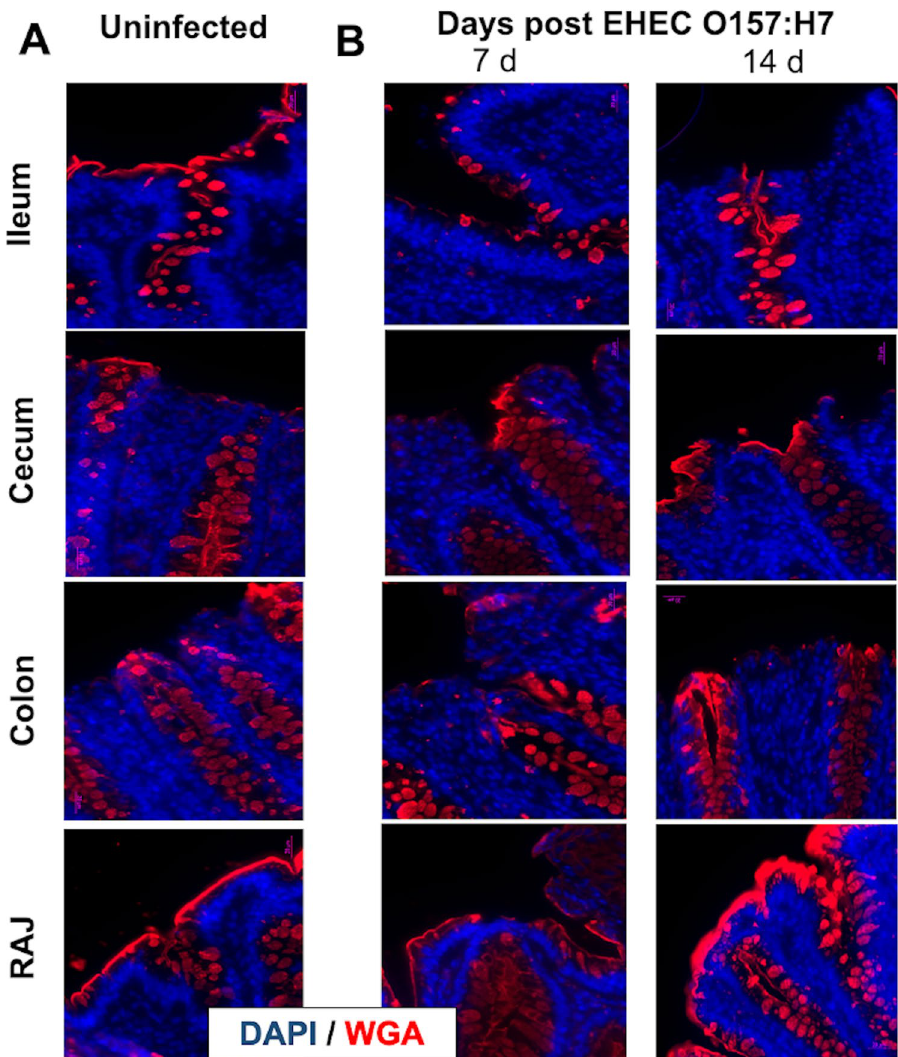
Figure 6. Microphotographs (lectin immunofluorescence with lectin wheat germ agglutinin; WGA) of cells producing N-acetyl-D-glucosamine and sialic acid (mucin) in the ileum, cecum, colon, and rectal anal junction (RAJ) of calves ( A ) uninfected and ( B ) challenged by EHEC O157: H7 (7 d and 14 d post-challenge). Infected small and large intestine displayed altered production of mucin glycoproteins with disparate production in the ileum, cecum, and colon and increased synthesis of mucin in RAJ at 14 d